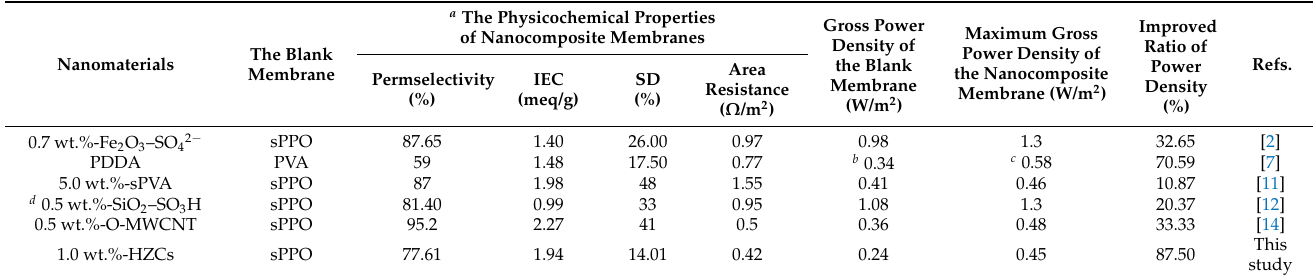
Table 1. Properties and power density of the nanocomposite membranes in a RED